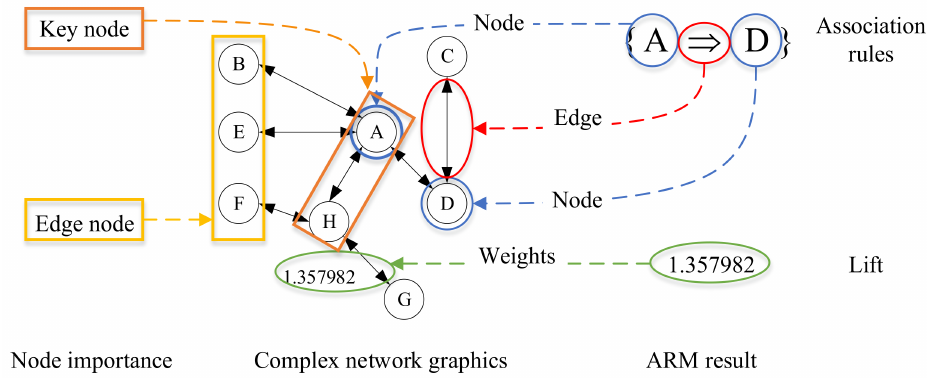
Figure 8. Mapping ARM results to complex